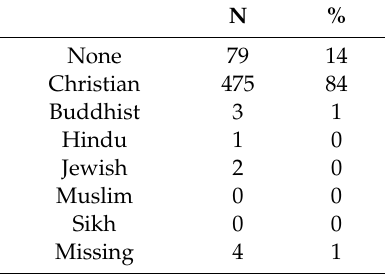
Table 8. Religious a ffi